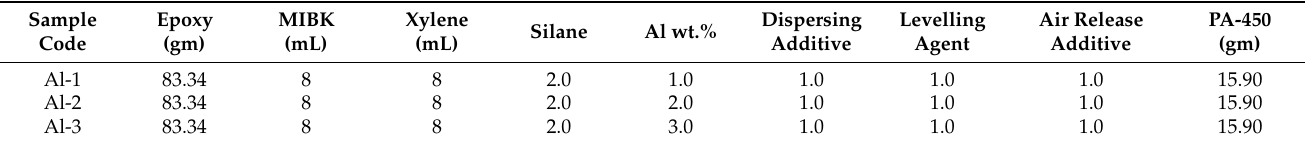
Table 1. Epoxy formulating ingredients for the fabricated coatings containing Al